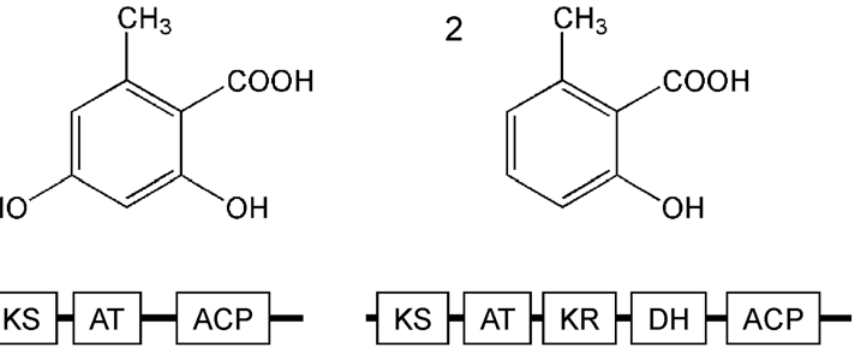
Figure 1. Comparison between orsellinic acid (1) and 6-methylsalicylic acid (6-MSA) (2), and the architecture of the corresponding polyketide synthase genes. Keto synthase (KS), acyl transferase (AT), keto reductase (KR), dehydratase (DH), and acyl carrier protein (ACP) are indicated as boxes. While orsellinic acid has only been characterized in bacteria, 6-MSA synthases with identical architecture have been found in bacteria and ascomycete